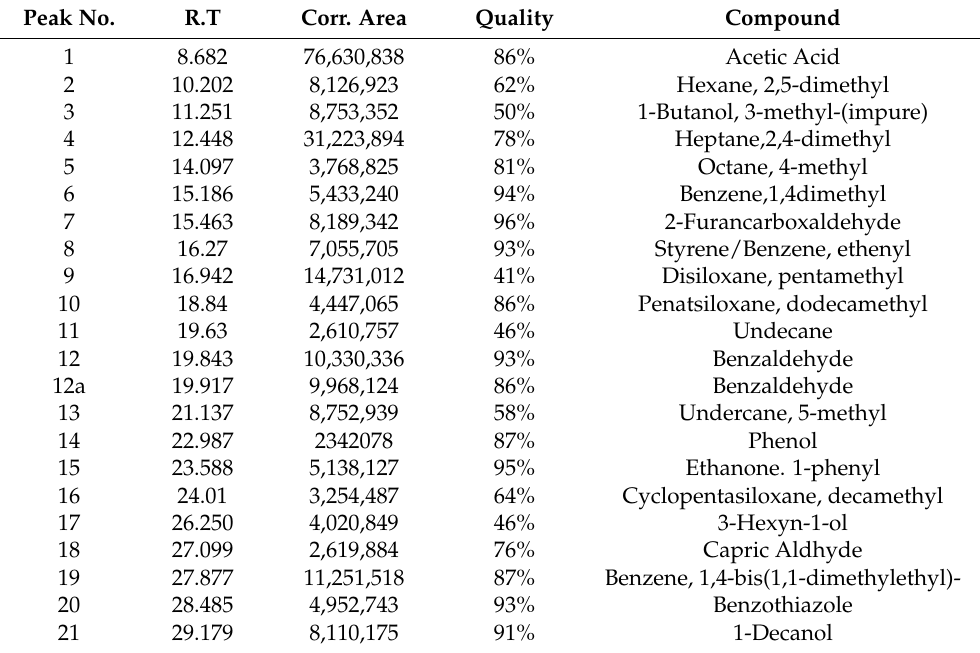
Table 4. Volatile organic compounds (VOCs) detected from samples of B. bassiana . Peak